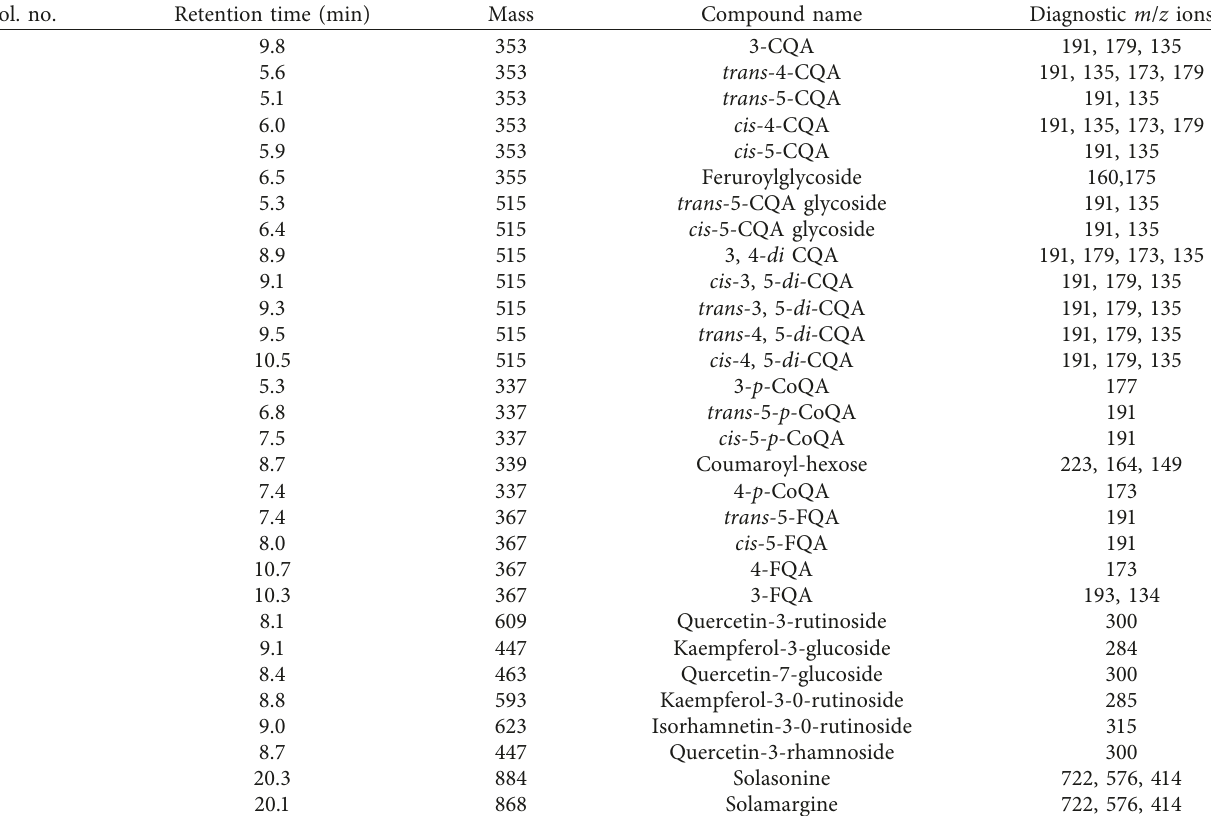
Table 1: Compounds identified with UHPLC in Solanum retroflexum leaf aqueous methanol extracts. Mol.